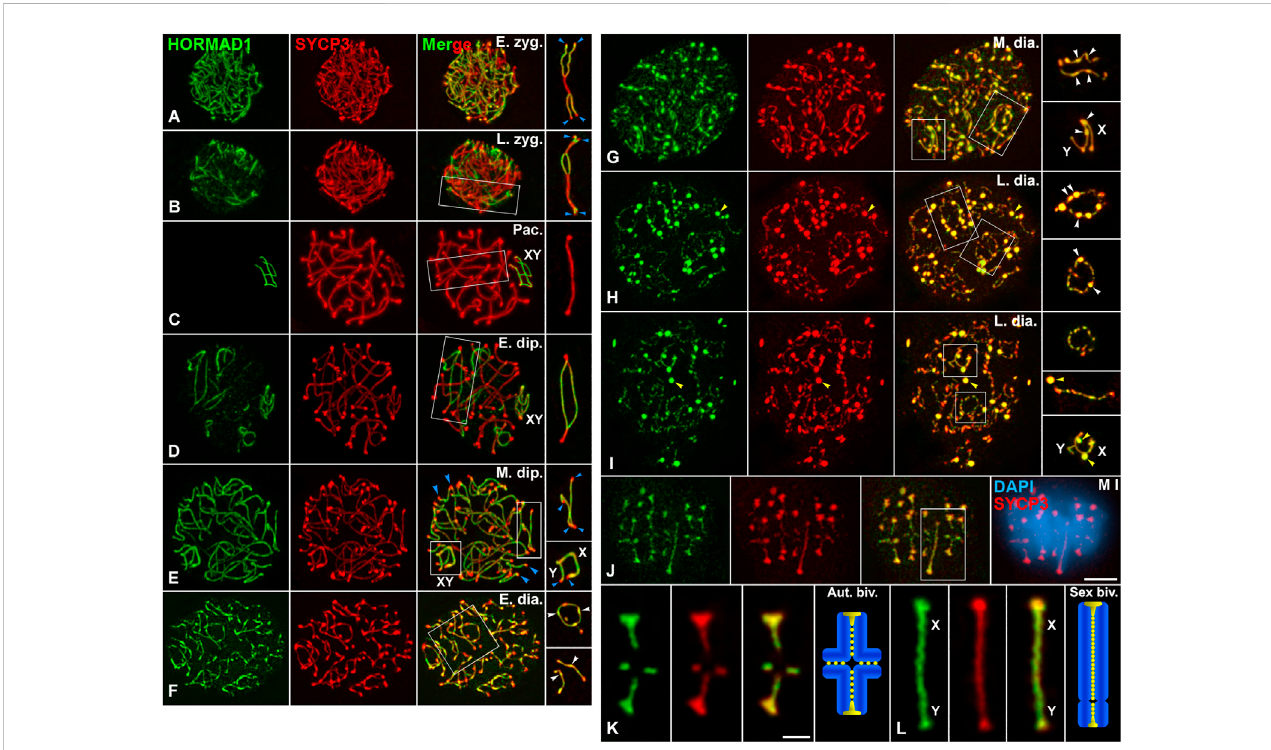
FIGURE 1 HORMAD1andSYCP3aresimilarlyreleasedfromtheLEsduringthediakinesis/metaphaseItransition.DoubleimmunolabelingofHORMAD1(green)and SYCP3 (red), and counterstaining of the chromatin with DAPI (blue) on squashed WT spermatocytes. Representative spermatocytes at (A) early zygotene (E. zyg.), (B) late zygotene (L. zyg.), (C) pachytene (Pac.), (D) early diplotene (E. dip.), (E) mid diplotene (M. dip.), (F) early diakinesis (E. dia.), (G) mid diakinesis (M. dia.), (H,I) latediakinesis(L.dia.),and (J) metaphase I(MI)spermatocytes areshown. (K,L) SelectedmetaphaseIautosomal(Aut.biv.) (K) andsex(Sexbiv.) (L) bivalents. The sex body (XY) is indicated if recognizable. Selected autosomal and sex (XY) bivalents in squared regions are shown in the right column (A – J) and the lower right line (K,L) . Blue arrowheads indicate telomere regions with absence of HORMAD1 labeling. White arrowheads indicate elongated bulges and round thickenings of HORMAD1 and SYCP3 along desynapsed autosomal LEs, and asynapsed AEs of the X chromosome. Yellow arrowheads indicate HORMAD1 and SYCP3 agglomerates in the nucleoplasm of late diakinesis spermatocytes (H,I) . Scale bars represent 5 μ m in (A – J) , and 2 μ m in (K,L)